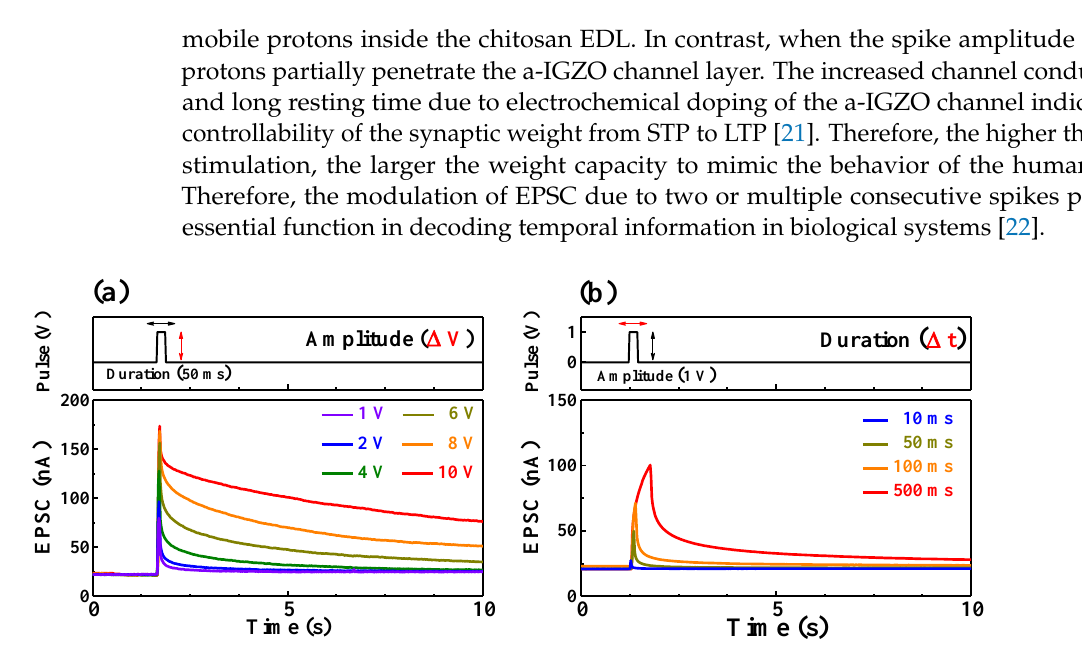
Figure 3. Excitatory postsynaptic current (EPSC) retention characteristics by a single gate pulse with ( a ) amplitude (1 to 10 V) variation for a fixed duration and ( b ) duration (10 to 500 ms) variation for a fixed amplitude.